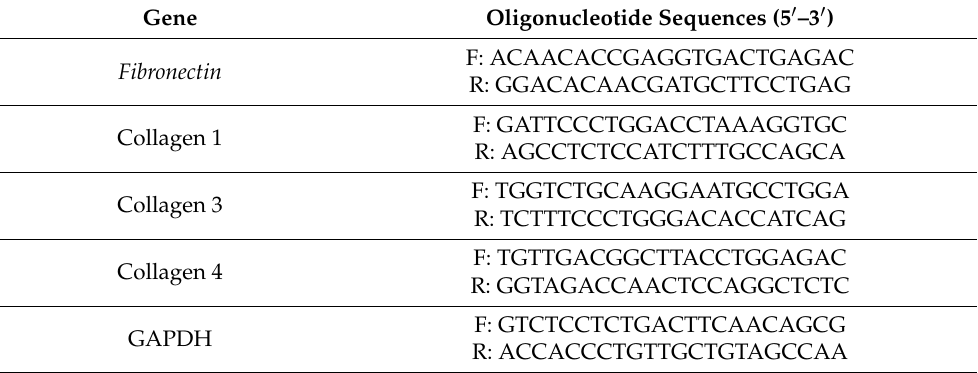
Table 1. Primers used in the real-time